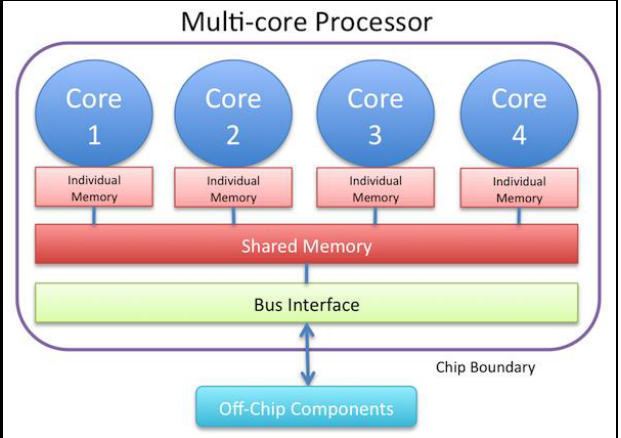
Figure 3. Multi-core